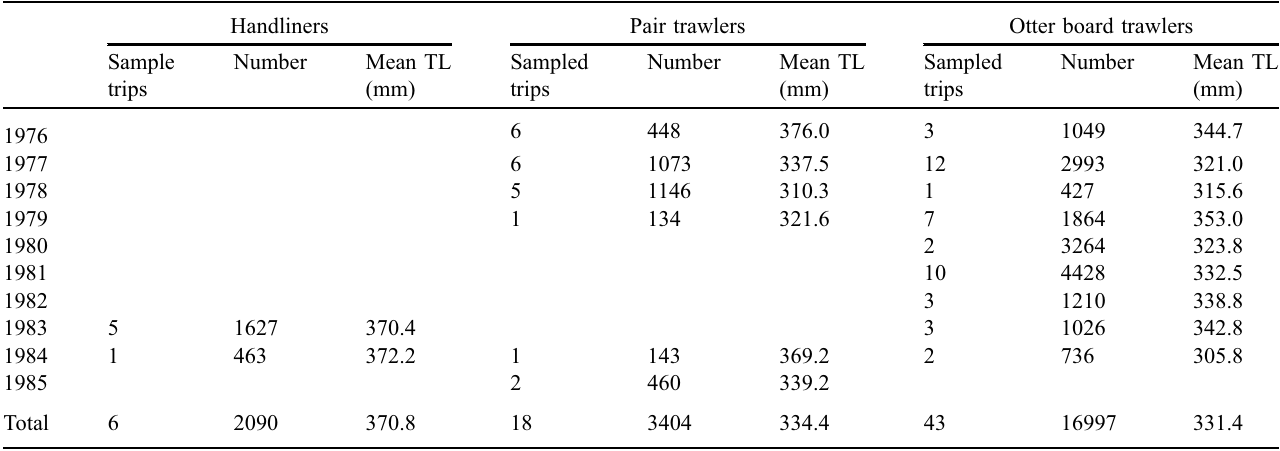
Table 1. Number of sampled fi shing trips, number of measured specimens and mean total length of Pagrus pagrus landed by handliners, pair trawlers and otter board trawlers in southern Brazil between 1976 and 1985.